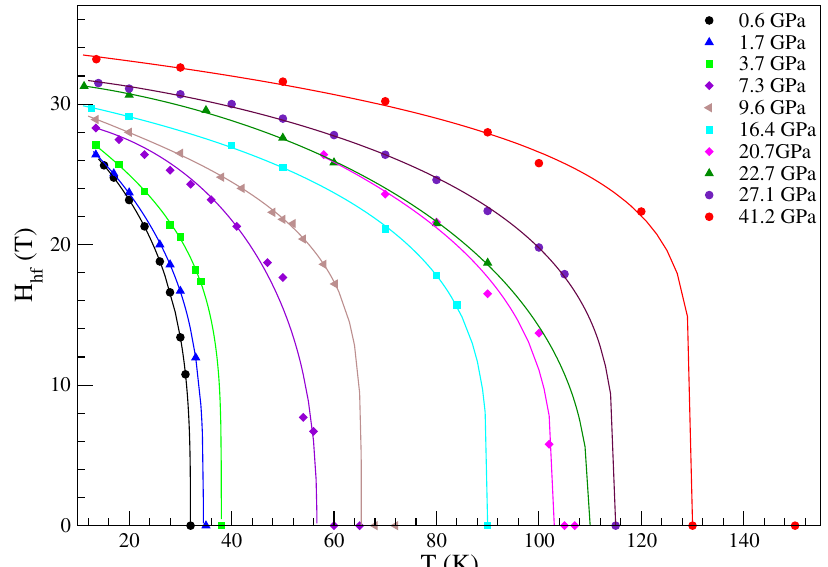
Fig. 4 Magnetic hyper fi ne fi eld under compression. Magnitude of internal magnetic hyper fi ne fi elds increase with pressure at a given temperature up to 41.2 GPa, yet these values drop with increasing temperature for a given pressure. The solid lines through the data are guides to the